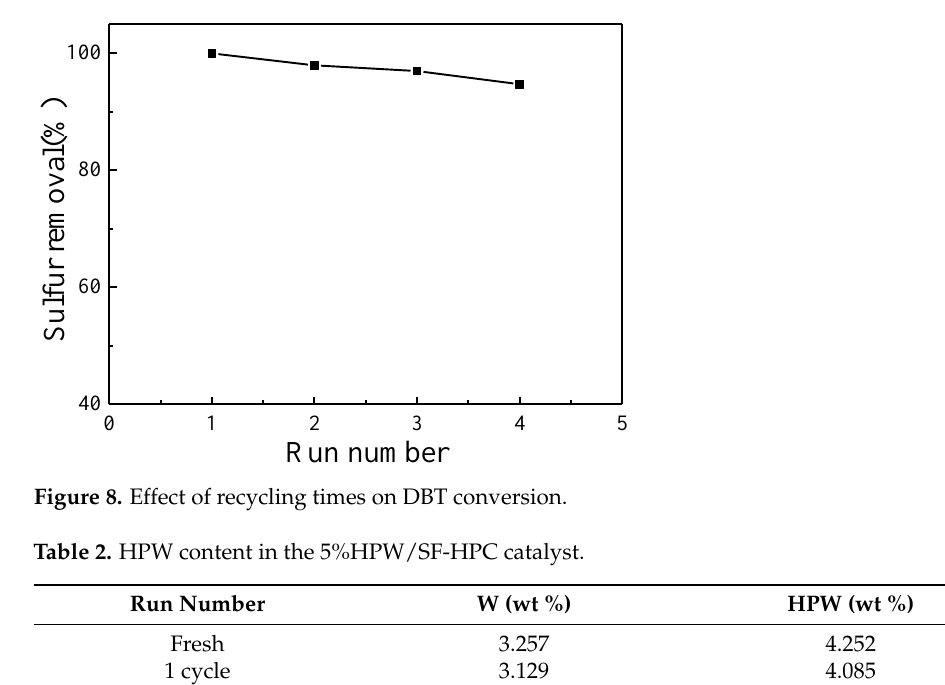
Figure 7. ( A ) Effect of reaction time (T = 25 °C, O/S = 10, and catalyst dosage = 0.1 g/10mL). ( B ) Effect of O/S molar ratio (T = 25 °C, t = 30 min, and catalyst dosage = 0.1 g/10mL). ( C ) Effect of catalyst dosage (t = 30 min, T = 25 °C, and O/S = 10).